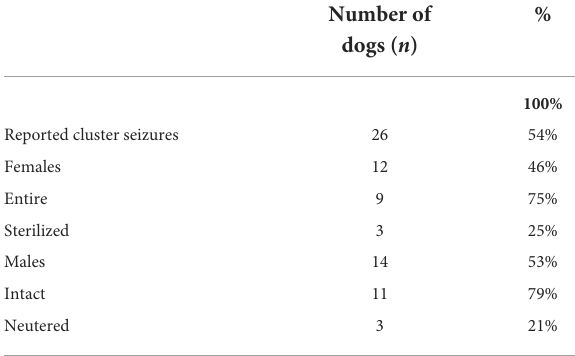
TABLE 1 The occurrence of CS as reported for male and female